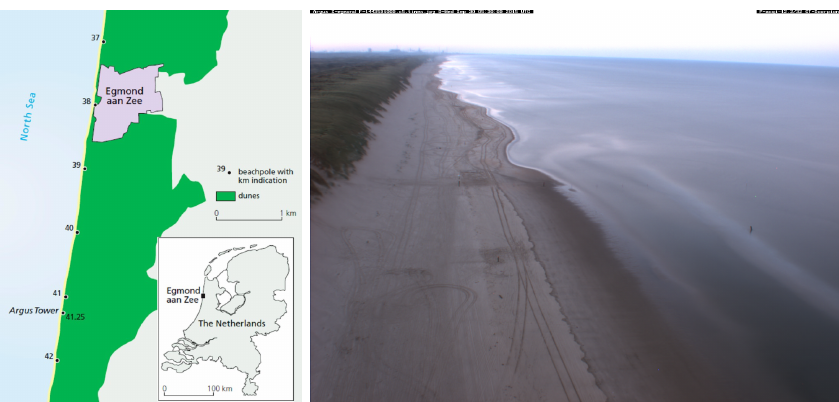
Figure 1. The study site is located south of Egmond aan Zee, between beach poles 41 and 42. The photograph on the right was taken from the Argus tower [35] and illustrates that the beach is fairly narrow and backed by a high